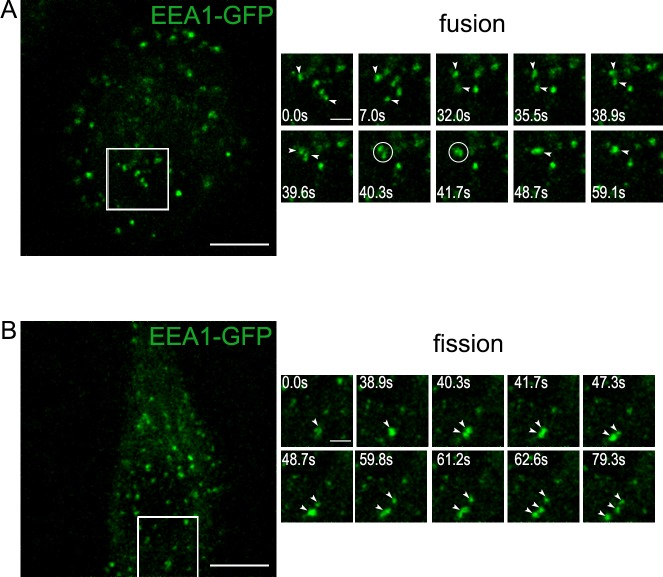
Live imaging of EEA1-vesicles population in serum-starved, non-stimulated Hela cells.The time-lapses present the fusion (A) and fission (B) events in serum-starved HeLa cells transiently expressing EEA1-GFP. The time after start of imaging is indicated at the frames. Scale bars– 10 μm (whole cell) or 3 μm (ROI time-lapse). Arrowheads indicate vesicles of interest, circle (A)–the moment of fusion. Full movies are presented as S1 and S2 Movies, respectively.